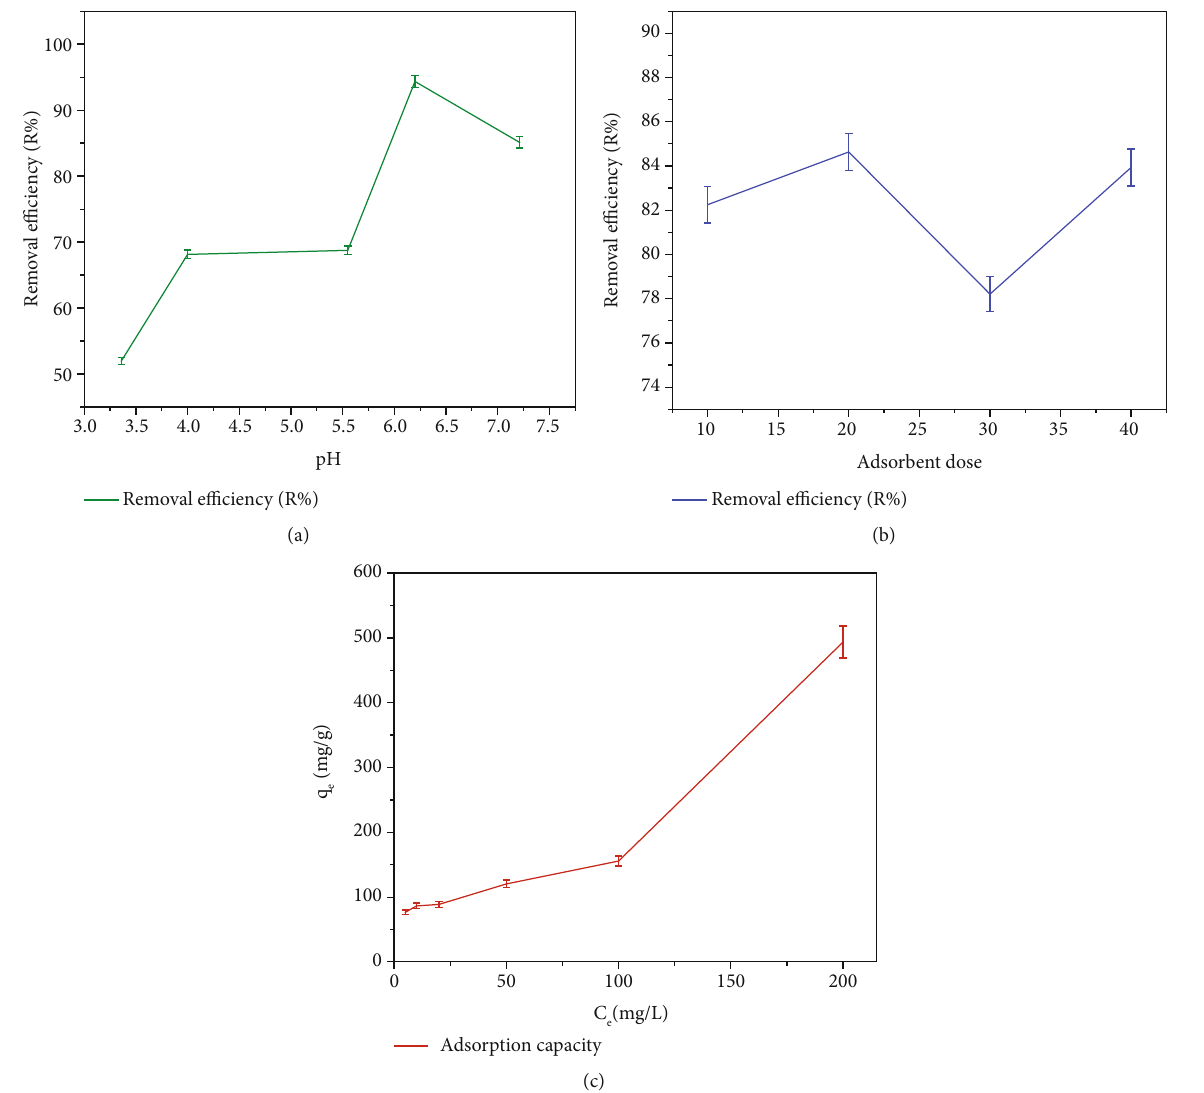
Figure 6: Impact of (a) pH, (b) initial concentration of Pb 2+ metal ions, and (c) C-PMMA/Mel2 dose of Pb(II) adsorption.